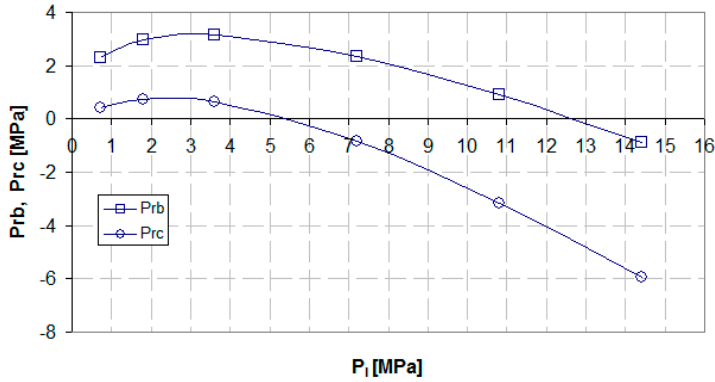
Figure 18. The variability in P rb and P rc as a function of the pressure P L for the coal from the Mesaverde Group, Piceance basin, Western Canada.